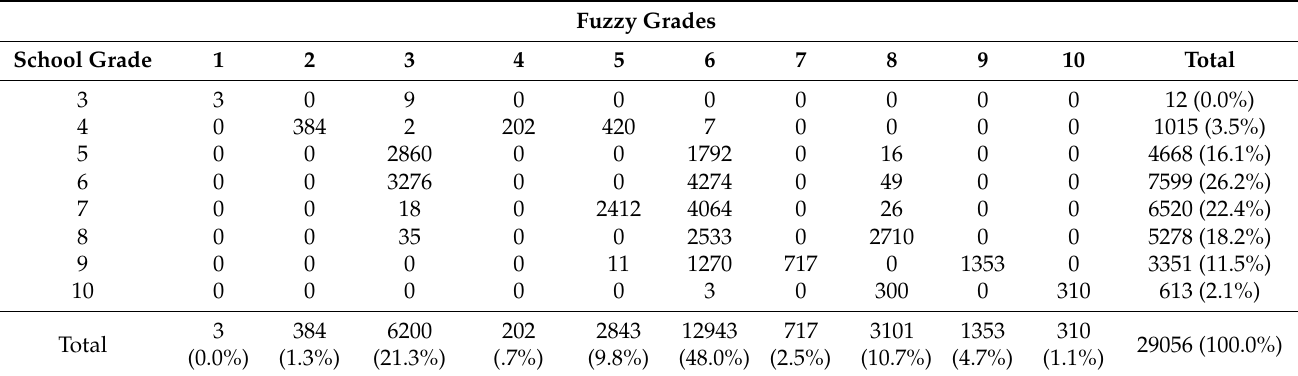
Table 7. The distribution of fuzzy grades among students with different school grades. Fuzzy Grades